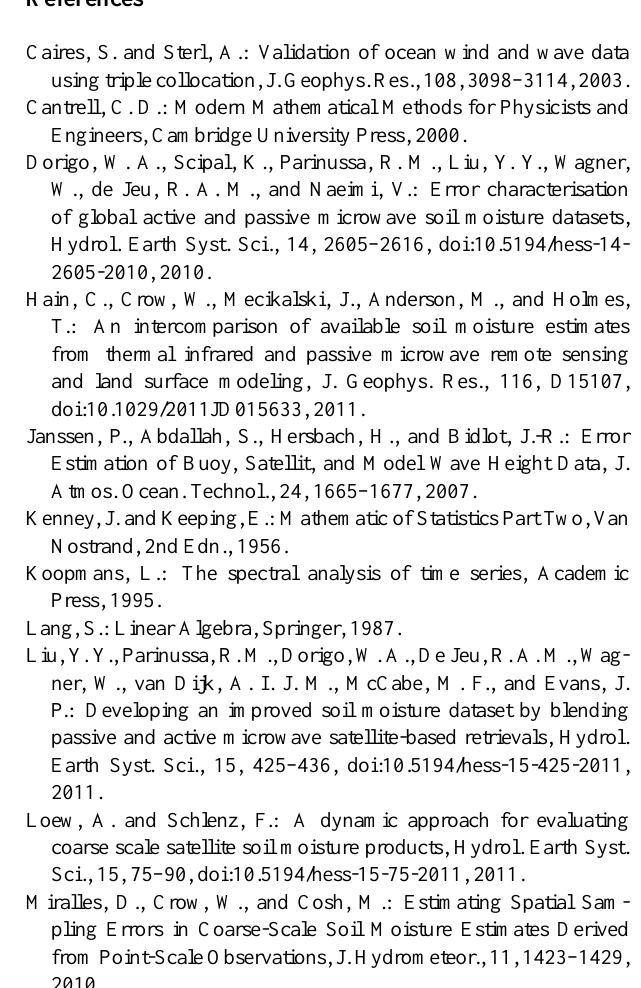
Fig. 8. Estimated variances ˆ σ 33 and covariance ˆ σ 23 when σ 12 is the only non-zero covariance ( Σ d ). The bias between the two estima- tors for both the variance and the covariance is due to the covariance not taken into account. The dashed lines indicate the correct values. Note that this example only differs from the one in Fig. 7 in the noise: this illustrates the structural deficiencies of the collocation technique.